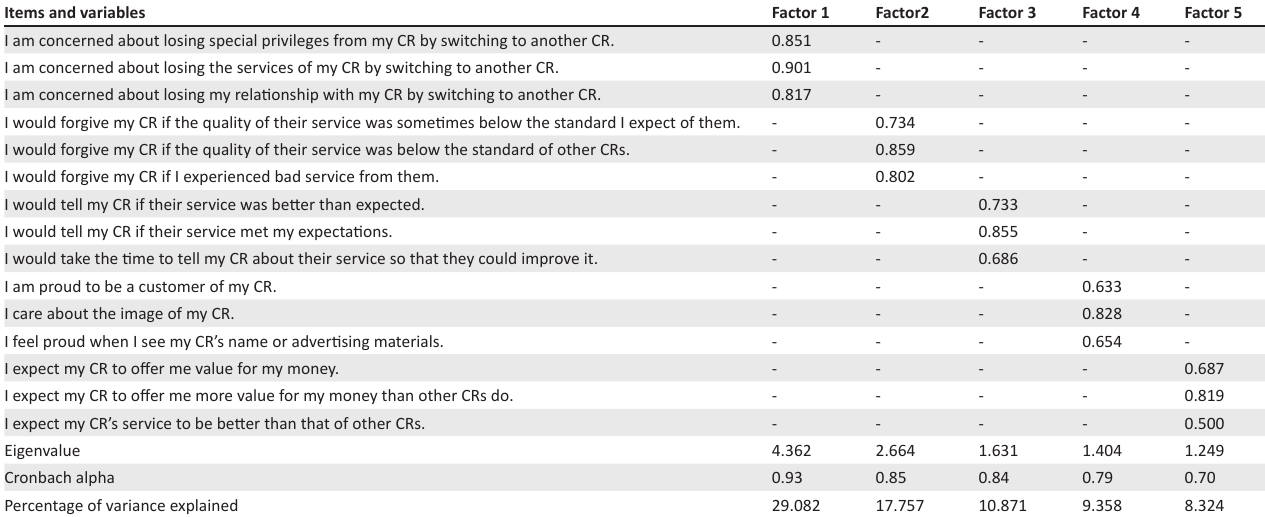
TABLE 2: Rotated pattern matrix for relationship intention in a clothing retail context. Items and